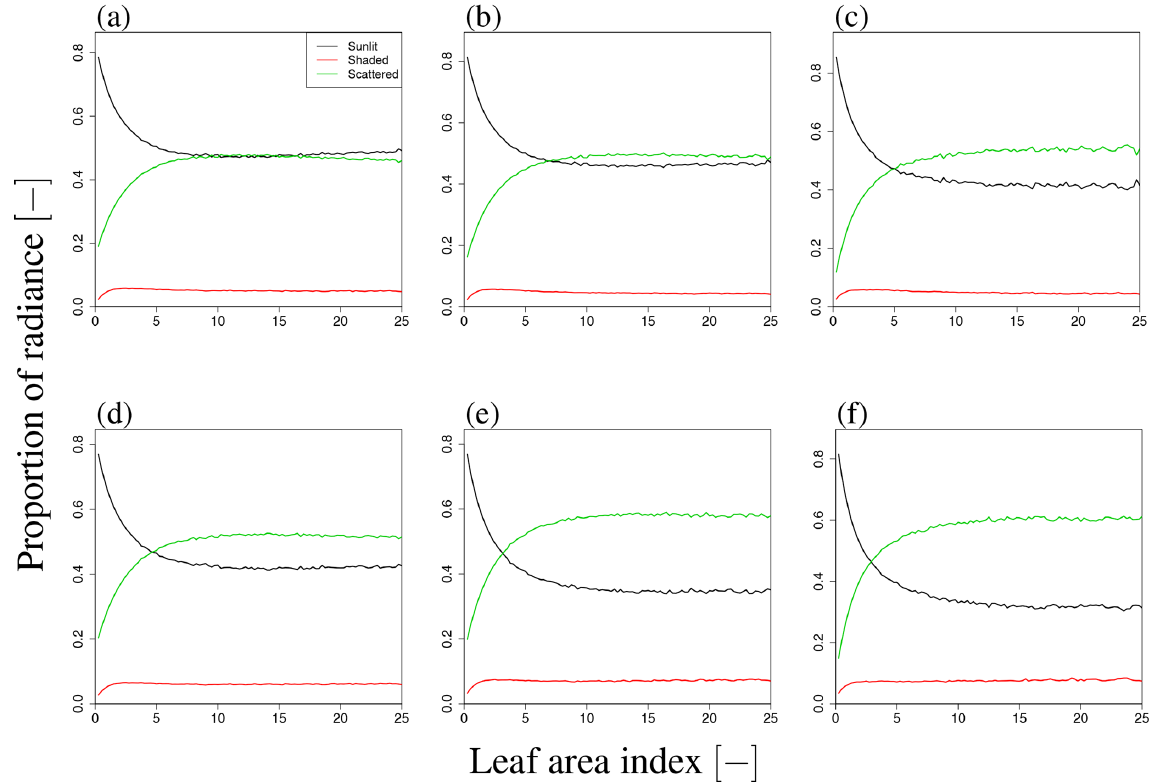
Figure 16. Proportion of SIF radiance in LAI variation. Panels (a) – (c) and (d) – (f) indicate results in forward and backward directions, respectively, for different VZA values (10 ◦ (a, d) , 30 ◦ (b, c) , and 50 ◦ (c, f) ). The contribution of shaded leaves is small and the contribution of scattered radiance increases with LAI and VZA. Additionally, in the backward direction, the contribution of scattered radiation to SIF is larger than that in the forward direction, similar to the angular